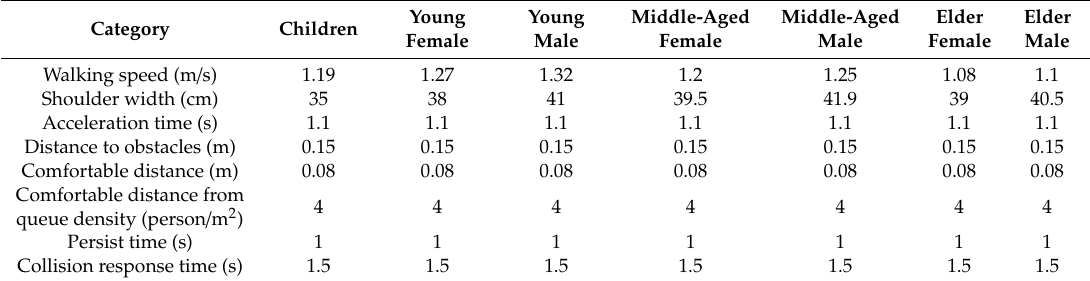
Table 8. Parameter setting of di ff erent sexes and age groups.